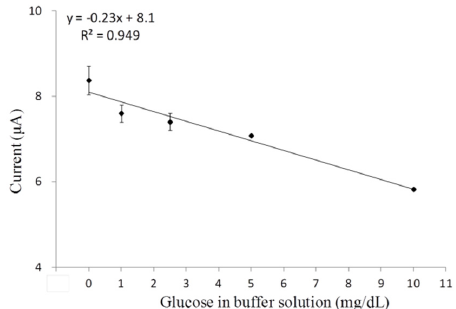
Figure 5. Cyclic voltammetry tests determined steady-state calibration curve of the single-walled carbon nanotubes/(chitosan/gold nanoparticles/glucose oxidase) 3 functionalized platinum electrode. Error bars = ±standard deviation and n = 3.